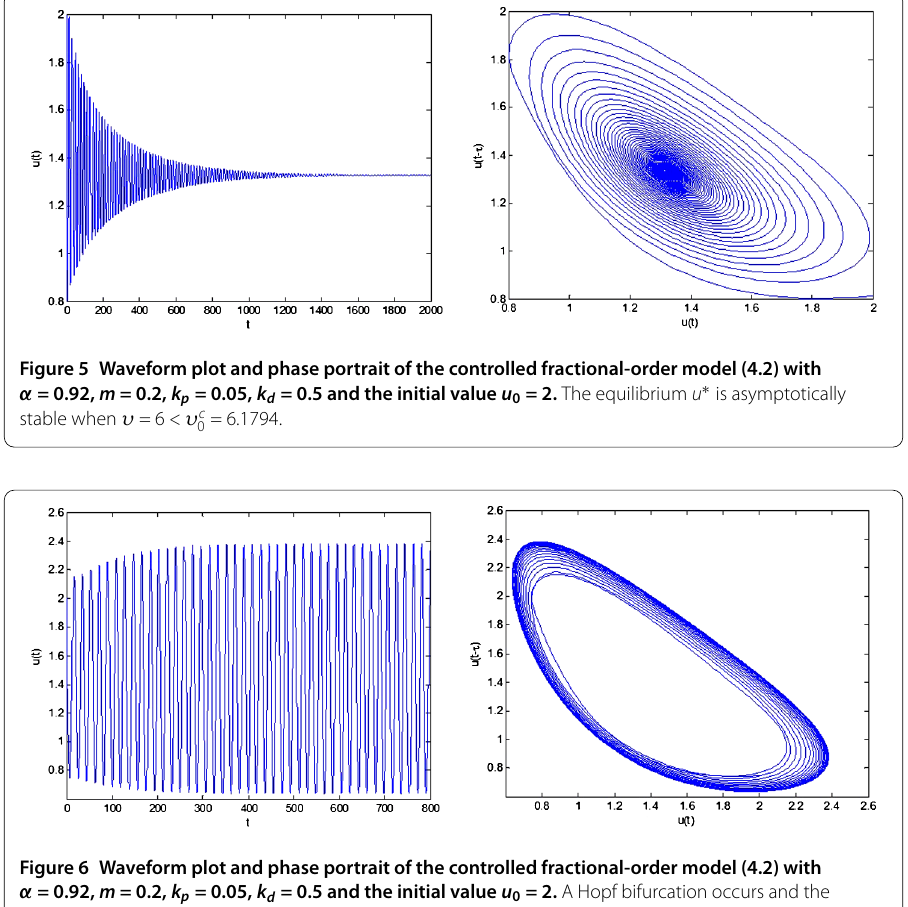
can successfully delay or advance the onset of Hopf bifurcation. Therefore, we can choose appropriate values of the Proportional and Derivative parameters to change the charac- teristics of Hopf bifurcation embedding in fractional-order systems with time